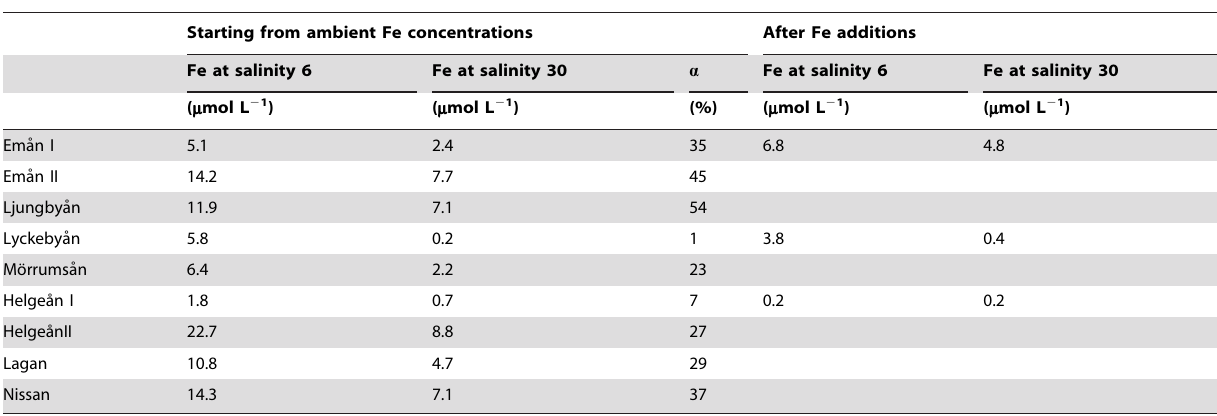
Table 3. Iron in suspension at different salinities and iron transport capacity ( a ) for the different waters.